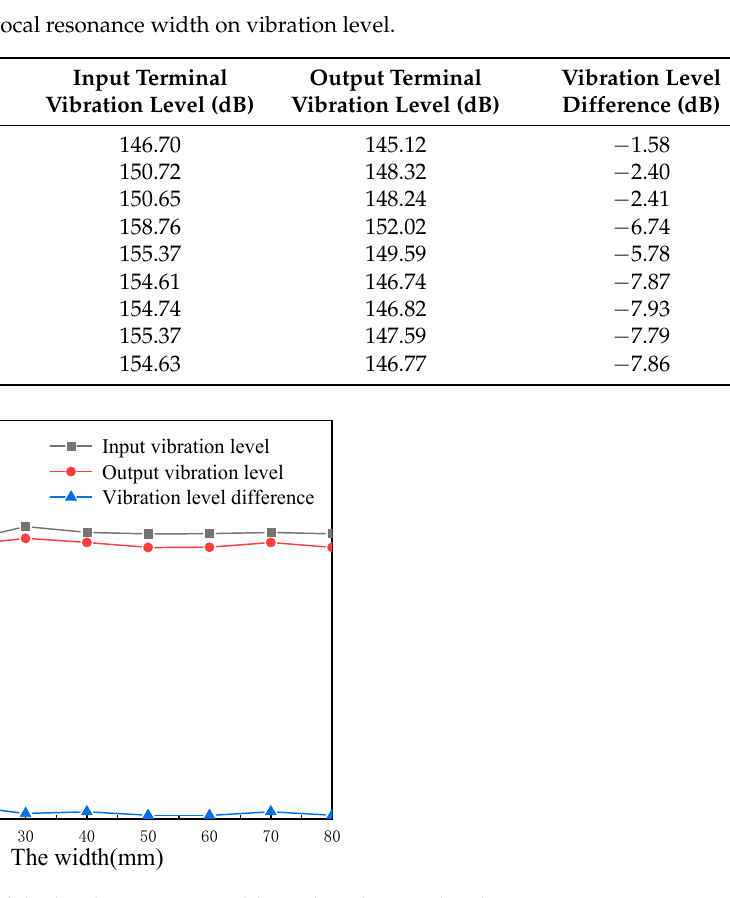
Figure 19. The effect of the local resonance width on the vibration level. According to Figure 19, the cushioning performance of offshore periodic truss platform is better than that of traditional offshore platform. As the width of local resonance increases, the vibration level of the offshore periodic truss platform input terminal decreases in turn, the vibration level of output terminal increases first and then decreases. The vibration level difference increases first and then decreases, the maximum of vibration isolation can reach to 7.93